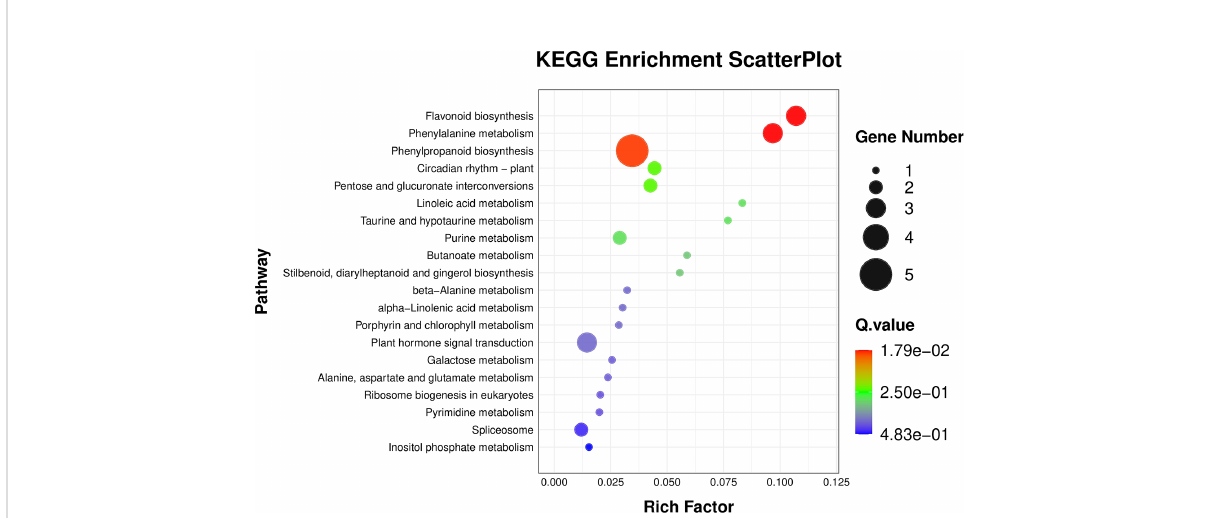
FIGURE 1 KEGG pathway enrichment scatter plot. The color of the point represents the size of the q-value. The smaller the q-value, the closer the point color to the red color. The point size expresses the number of differential genes in each